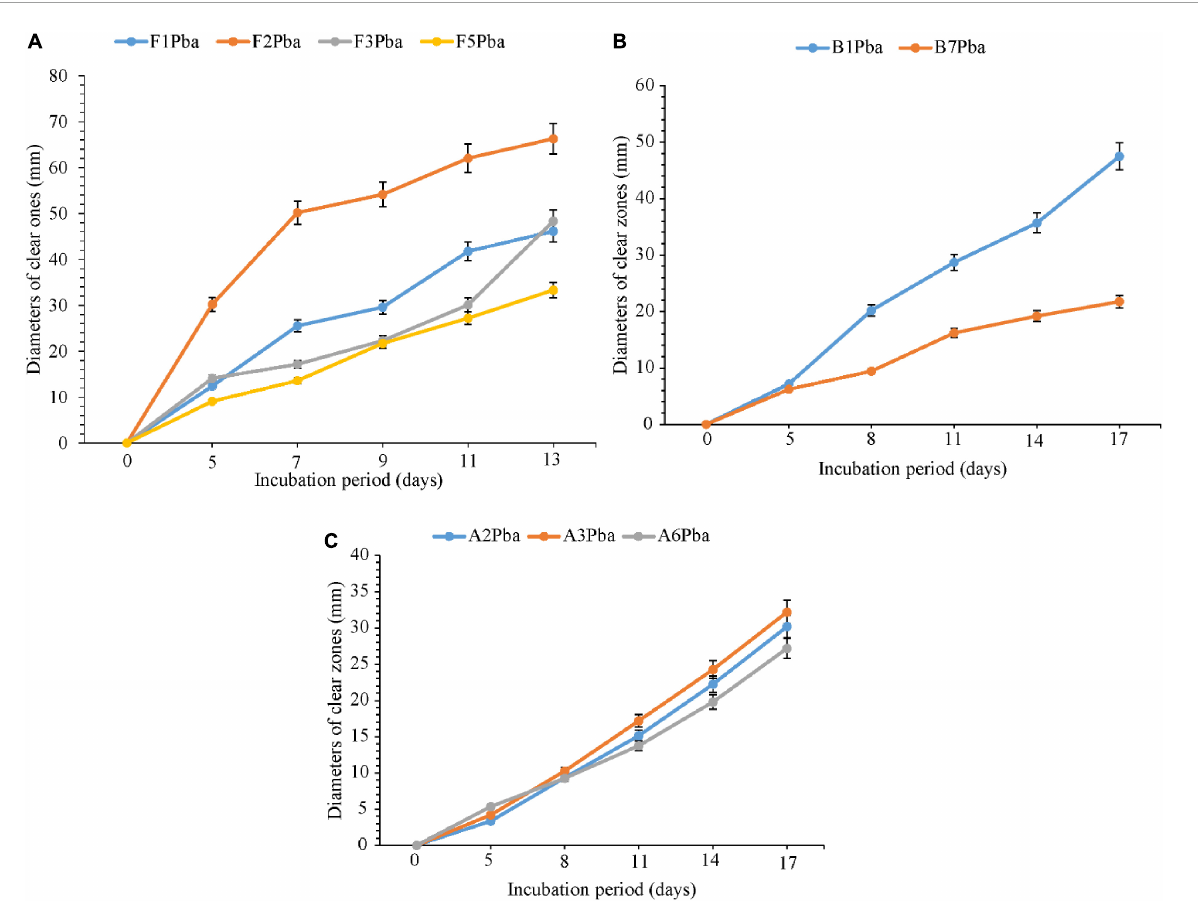
FIGURE3 Comparative ability of the (A) fungi, (B) bacteria, and (C) actinomycetes in degrading ground plastic bags. Error bars represent the mean ± SD of three independent biological replicates (the names of species coded with letters F represent fungi, B represents bacteria, and A represents actinomycetes, and the numbers represent their positions in a particular group as shown in Table 6